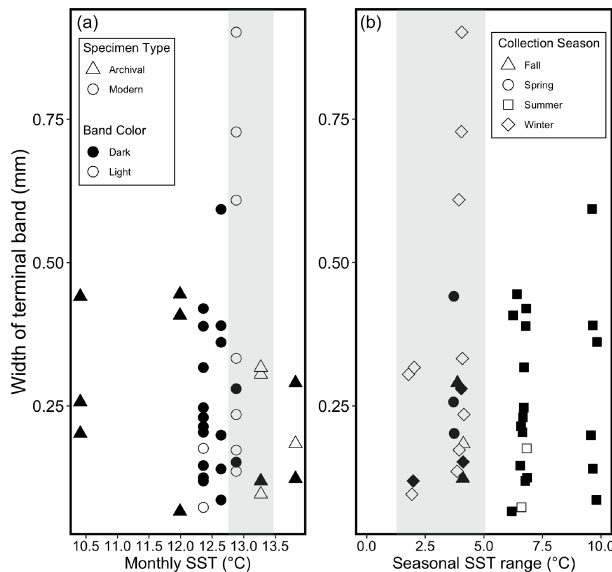
Figure 6. Relationships between SST, width of the terminal band, color of the terminal band, specimen type, and collection season for all 40 specimens. Filled (black) points represent dark termi- nal bands, and open (white) points represent light terminal bands in both plots. (a) Relationships between mean monthly SST during the month of collection, color of the terminal band, and width of the terminal band. Shaded bar represents approximate monthly SST range over which most specimens are associated with light terminal bands (12.75–13.5 ◦ C). Specimen type specified with point shapes (see legend a ). (b) Relationships between the seasonal SST range (mean daily SST maximum – mean daily SST minimum for each season of collection), color of the terminal band, and width of the terminal band. Shaded bar highlights that most terminal light bands are associated with a seasonal SST range < 5 ◦ C. Collection season specified with point shapes (see legend b